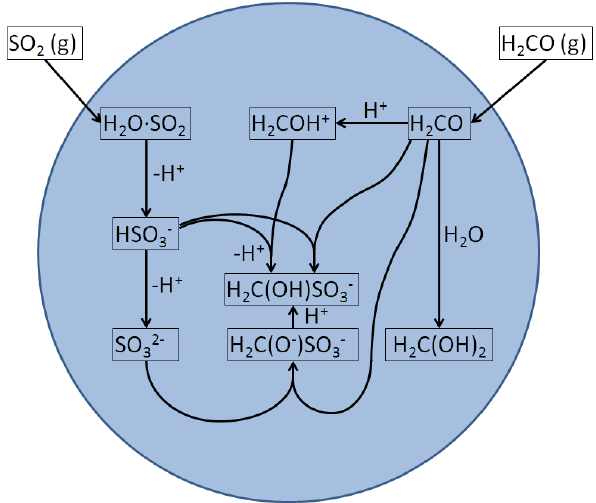
Fig. 1. Formation pathways of HMSA (Munger et al., 1984; Olson and Hoffmann, 1989). All reactions are equilibrium reactions. The circle indicates an atmospheric droplet.